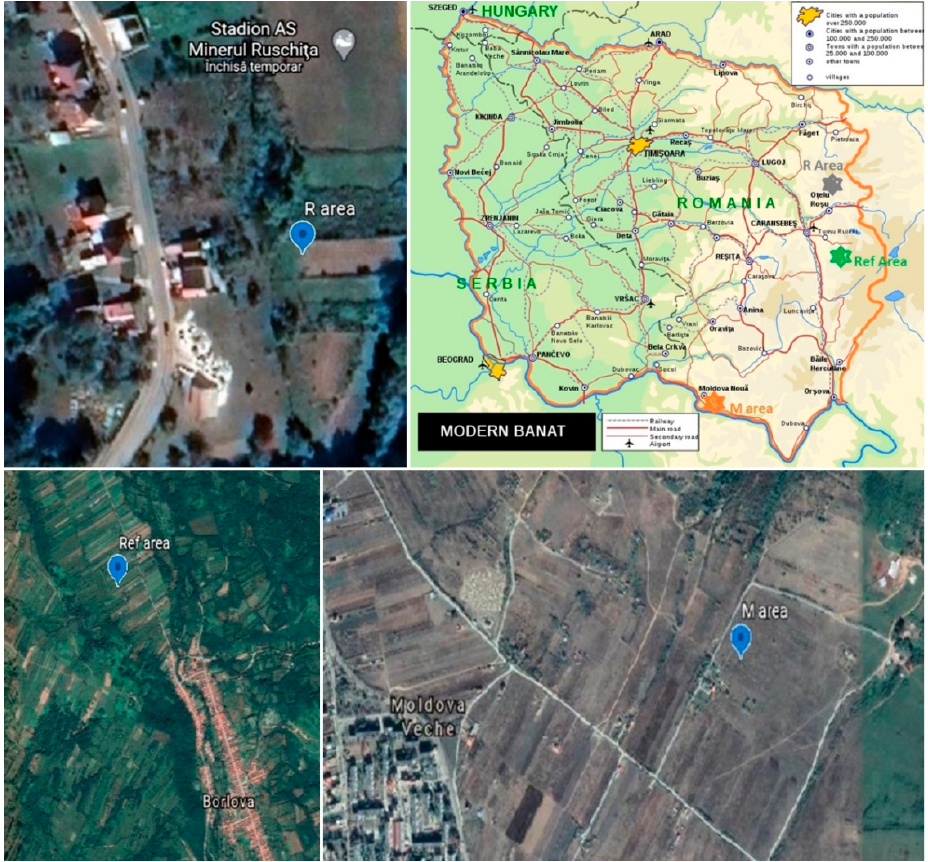
Figure 1. Locations of sampling areas. [37] and Google maps.